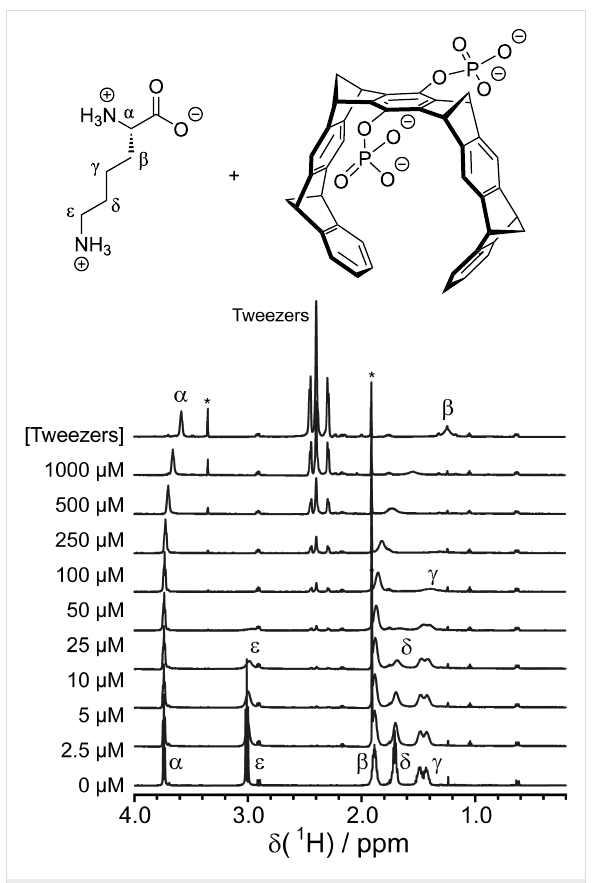
Figure 2: 1 H NMR titration of lysine with tweezers. All signals show chemical shift perturbations and different degrees of line broadening. The protons that are located right inside the tweezer cavity upon binding experience the largest effects. The asterisk marks impurities in the tweezers stock solution. Reprinted (reproduced) with permission from [80], copyright (2017) Wiley-VCH Verlag GmbH & Co.